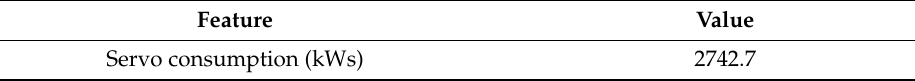
Table 20. Electric press’s main features necessary for the CF calculation [72].